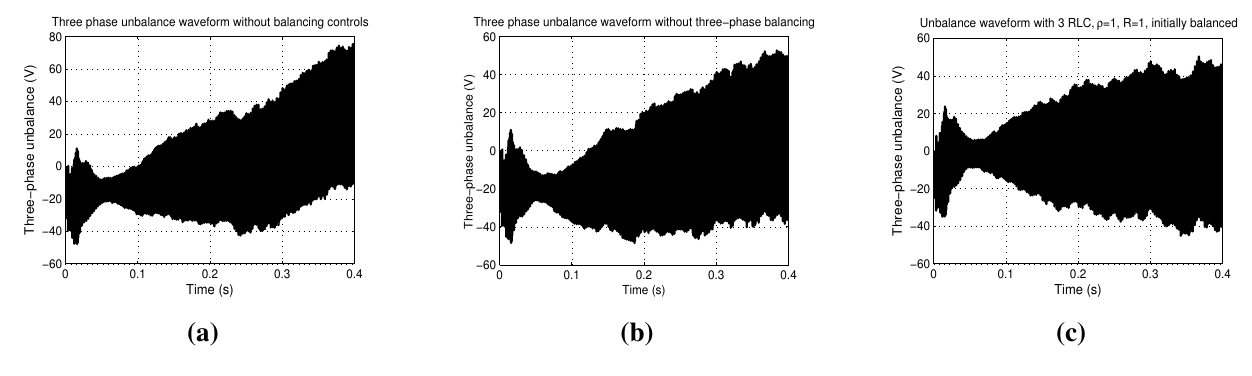
Figure 9. Three-phase capacitors balancing in different cases. ( a ) Without balancing; ( b ) with single-phase balanced circuits; ( c ) with all balancing